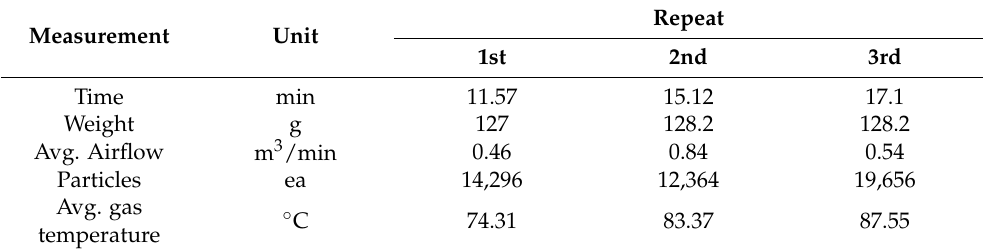
Table 1. Conditions for incineration experiment of waste mulching LDPE collected in